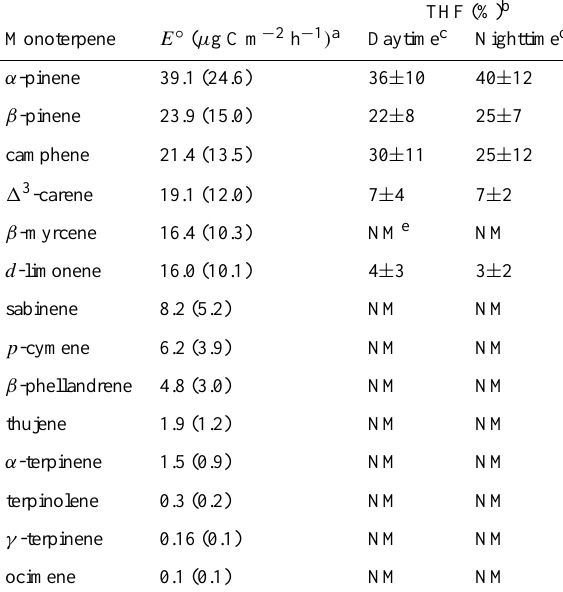
Table 2. Comparison between monoterpene emission fluxes calcu- lated by Geron et al. (2000) for forestland encompassing the THF site and relative monoterpene abundances from mixing ratios mea- sured by GC-FID at THF between 24 July and 15 August 2004.